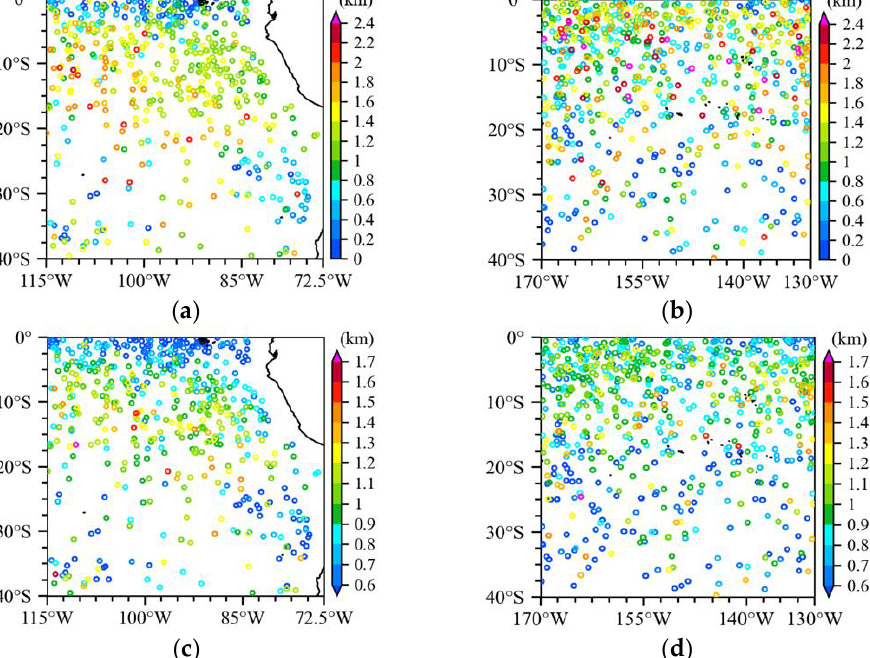
Figure 8. Spatial distribution of COSMIC-2 ROs in August 2020 within the SEP (left panels) and SCP (right panels) areas with the vertical gradient of N − N ( r ) less than − 65 N-unit km − 1 , in which ( a , b ) the lowest height and ( c , d ) PBL height are indicated,